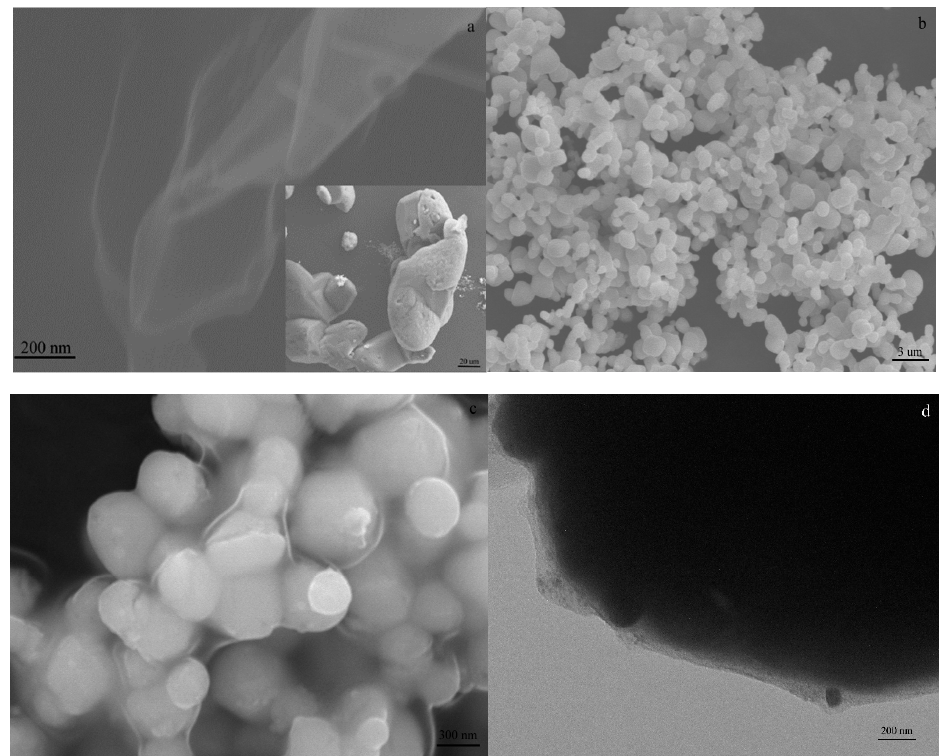
Figure 2. Scanning electron micrscope (SEM) images of ( a ) TCNQ nanosheet, insert: pure TCNQ ( b ) AgI, ( c ) AgI@TCNQ, and ( d ) transmission electron microscope (TEM) image of AgI@TCNQ.